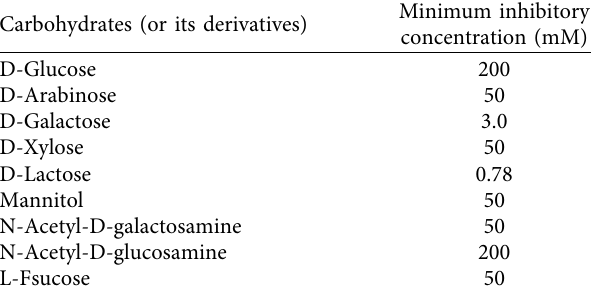
Table 2: Inhibition of hemagglutination activity of the LML by different